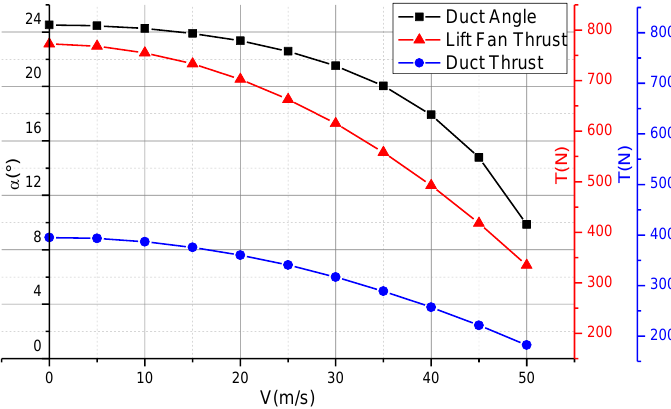
Figure 10. Lift fan and lift duct state curve when pitch angle is 2°.